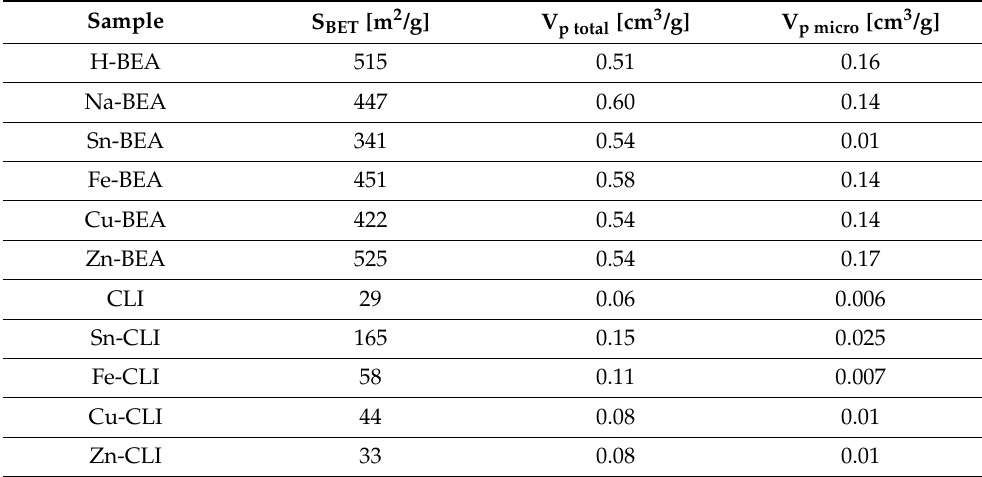
Table 1. Specific surface area and pore size of the zeolite catalysts. V p total is the total pore volume; V p micro is the micropore volume determined using the Saito-Foley (SF) model and calculated using the t-plot method.